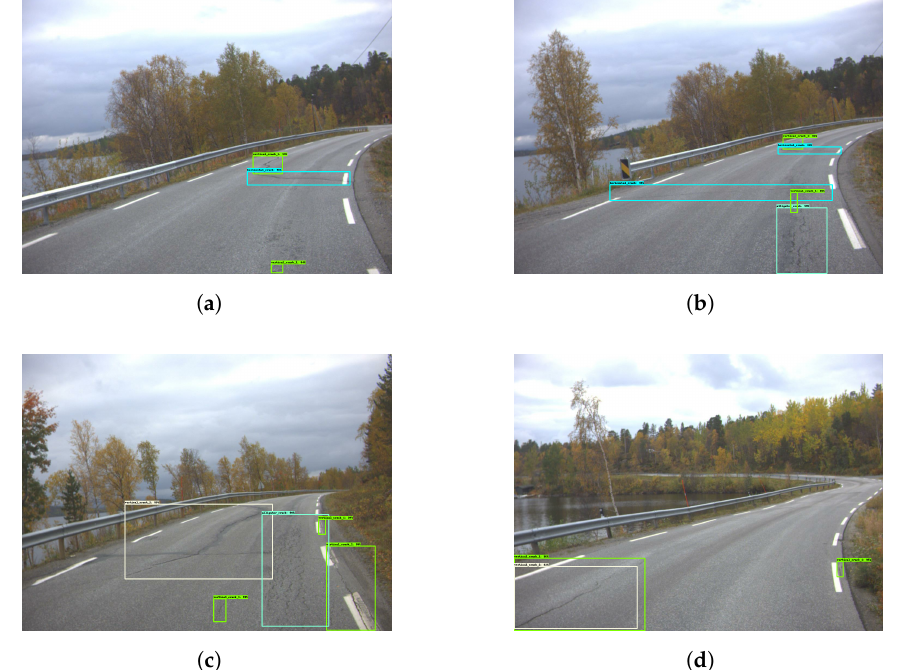
Figure 11. Damage detection—Model 2. The green and yellow boxes represent the vertical cracks while cyan colored boxes are the horizontal